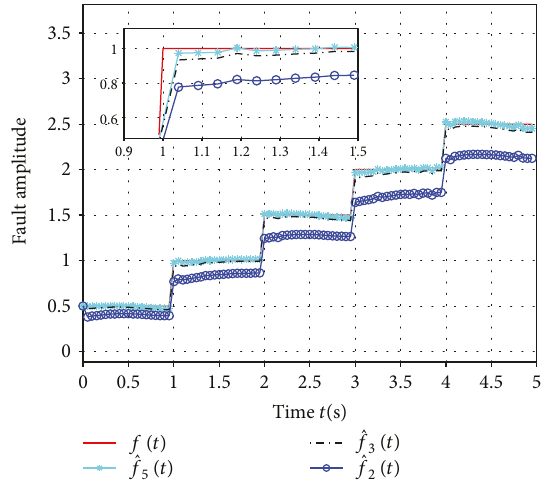
Figure 3: The tracking trajectory of intermittent fault for a nonlinear system with constant parameter uncertainties.